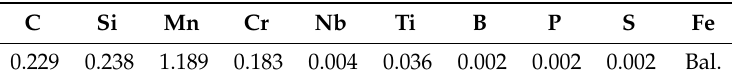
Table 1. Chemical composition (wt %) of Boron